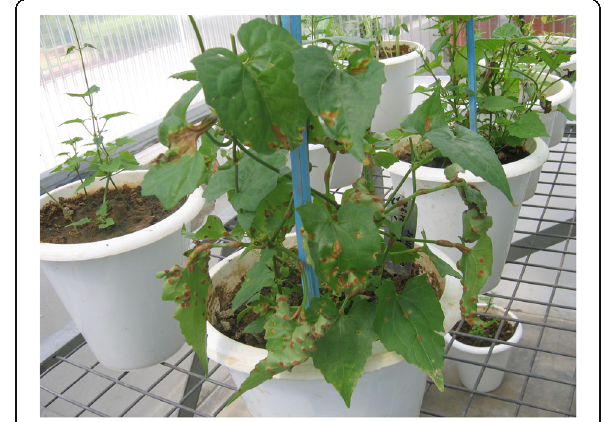
Fig. 4 A representative Mikania micrantha plant from Kerala infected with the Peruvian pathotype of Puccinia spegazzinii